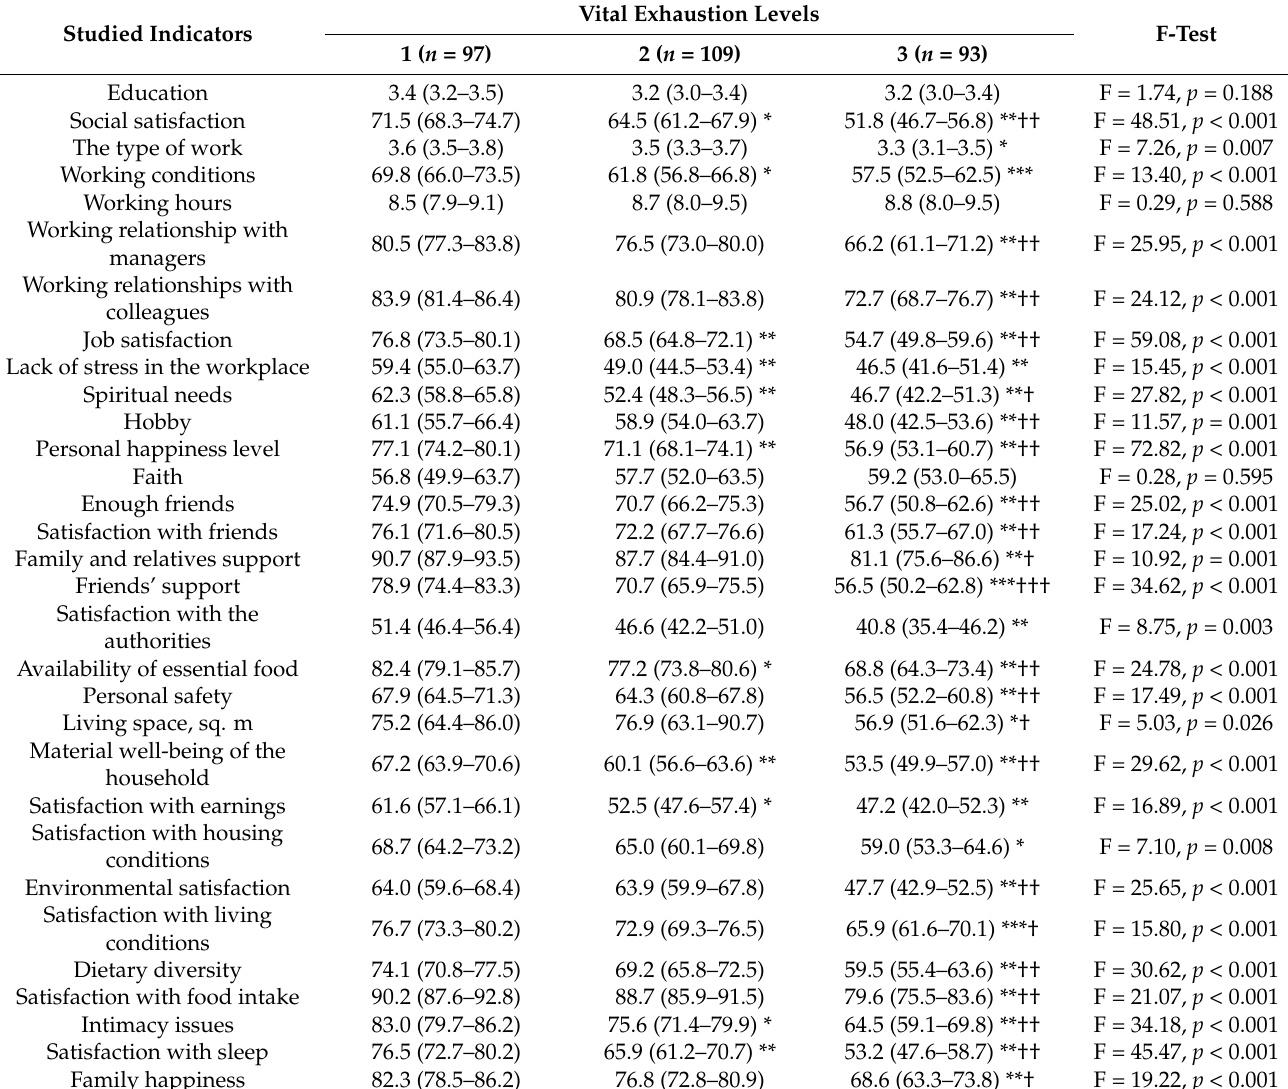
Table 4. Comparative analysis of indicators of psychosocial environment and lifestyle in groups of males with different vital exhaustion